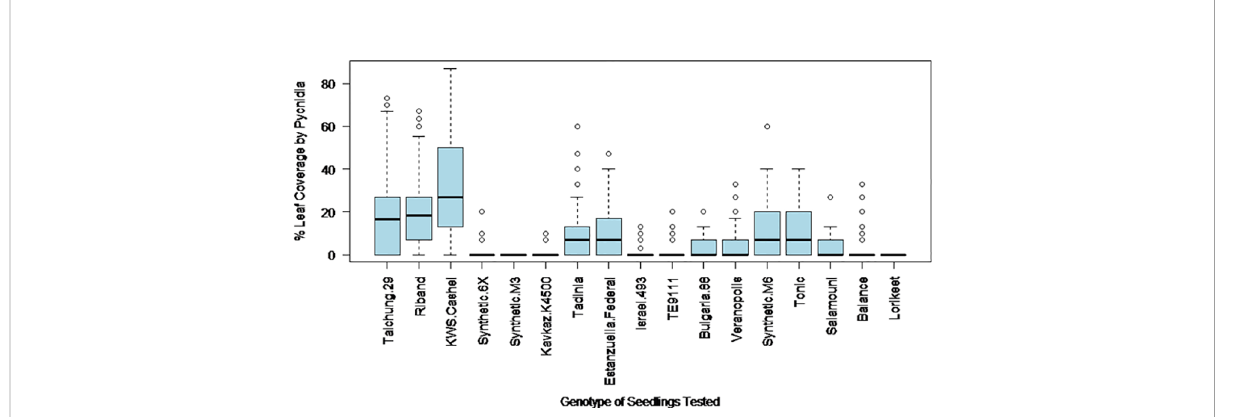
FIGURE 2 The variation in leaf coverage by pycnidia at 28 days post inoculation with different Z. tritici isolates on each of the 17 studied wheat genotypes.